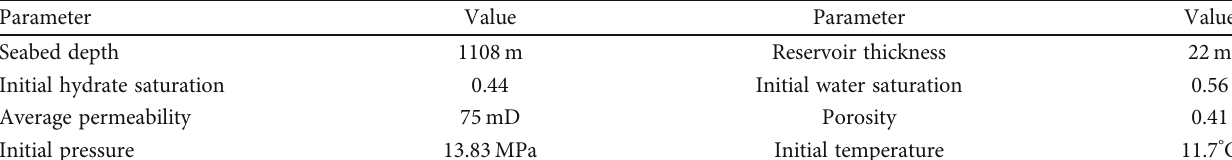
Table 2: Basic parameters of the hydrate reservoir model.